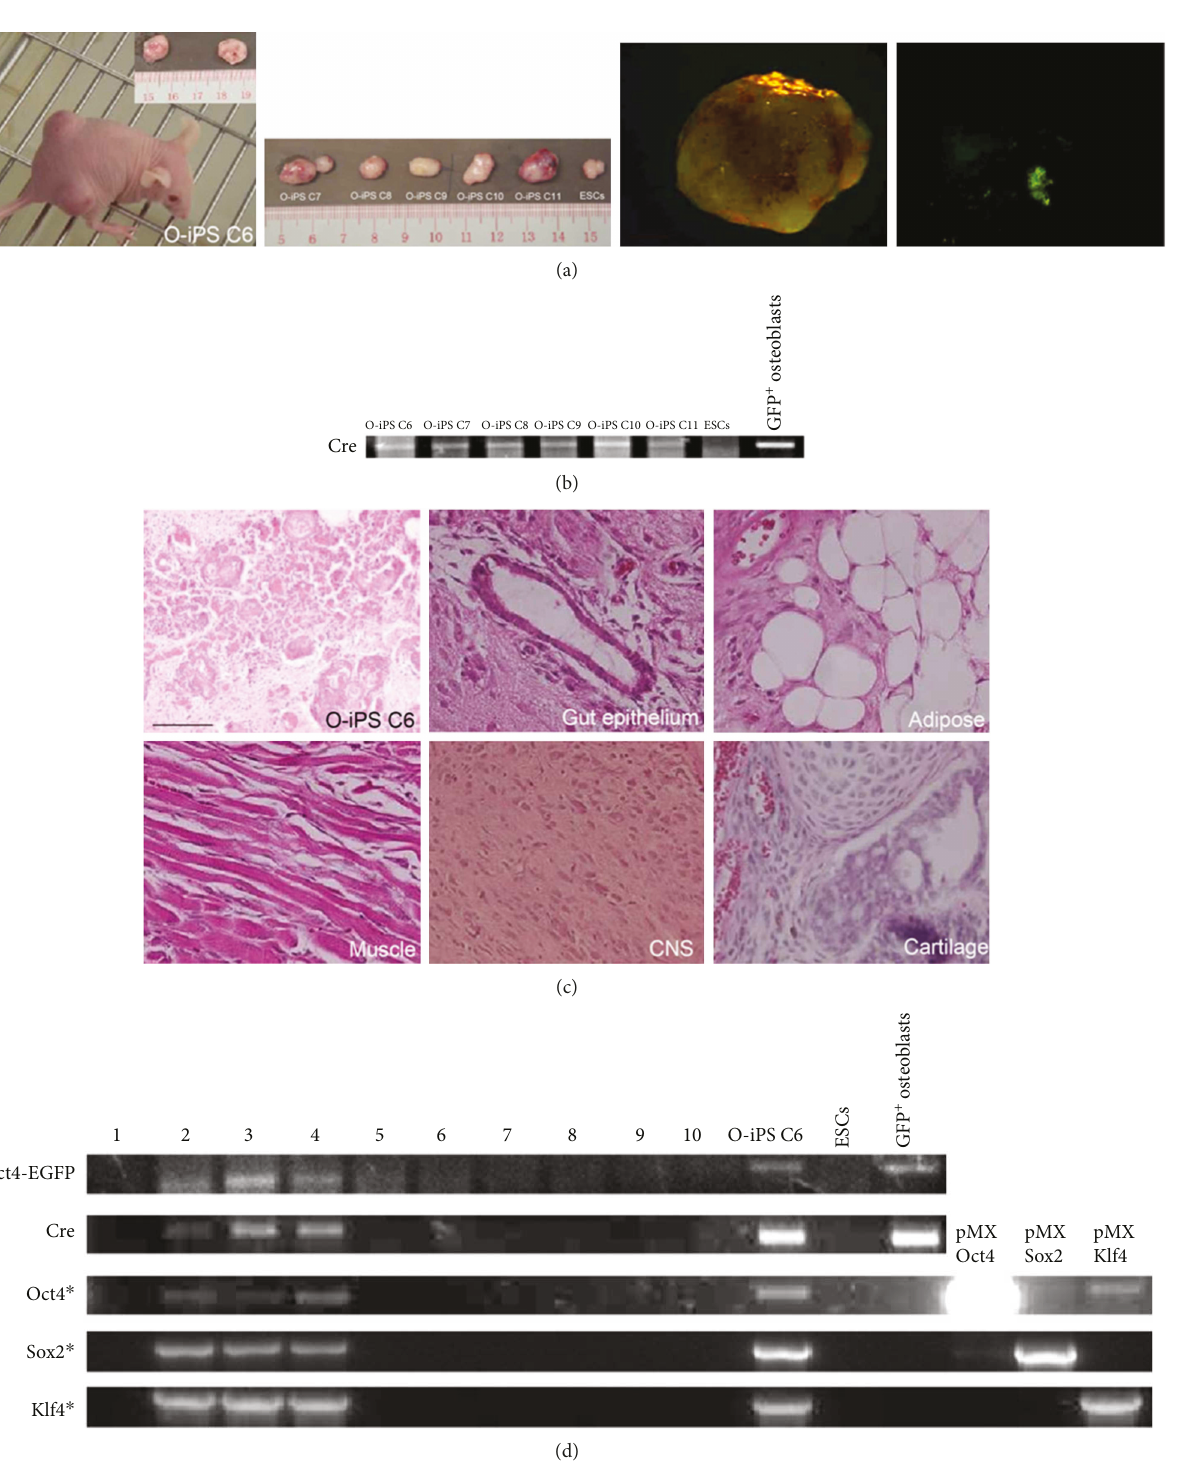
Figure 4: Pluripotent potential of O-iPS cells. (a) Formation of two teratomas derived from O-iPS6 cells under the skin in nude mice 4 weeks posttransplantation. Inset shows the size of teratomas harvested from nude mice. Teratomas derived from 5 di ff erent O-iPS cells and ESC- derived teratoma serves as a positive control. GFP expression was detected in an O-iPS6-derived teratoma. Scale bar: 1 cm. (b) Genotyping of teratoma tissues derived from 6 O-iPS colonies for Cre transgene. Sorted GFP + osteoblasts serve as a positive control. (c) H&E staining of teratoma sections showed di ff erentiation of O-iPS6 into various tissues from all three germ layers. CNS: central nervous system. Scale bar: 100 μ m. (d) Genotyping of coding regions for Oct4-EGFP , Cre , and integrated retroviral vectors carrying reprogramming factor genes ( Oct4 , Sox2 , and Klf4 ) on tail tissues derived from E17.5 chimera embryos. ESCs serve as a negative control. Sorted GFP + osteoblasts and retroviral vectors carrying reprogramming factors serve as positive